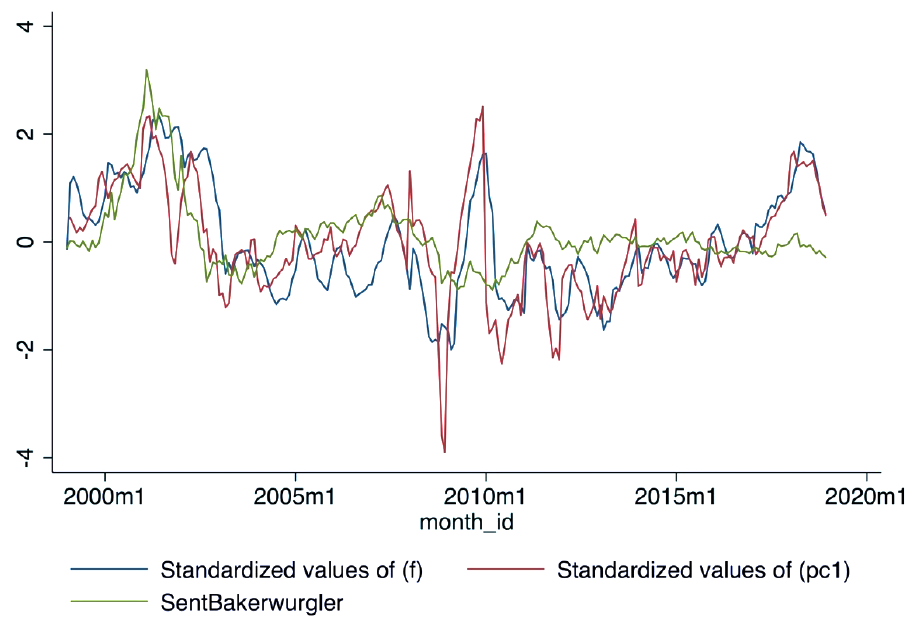
Figure 1. Comparison of standardized values of the proposed European sentiment index, standardized values of pc1 or EURsent index (Reis & Pinho, 2020b), and standardized values of US